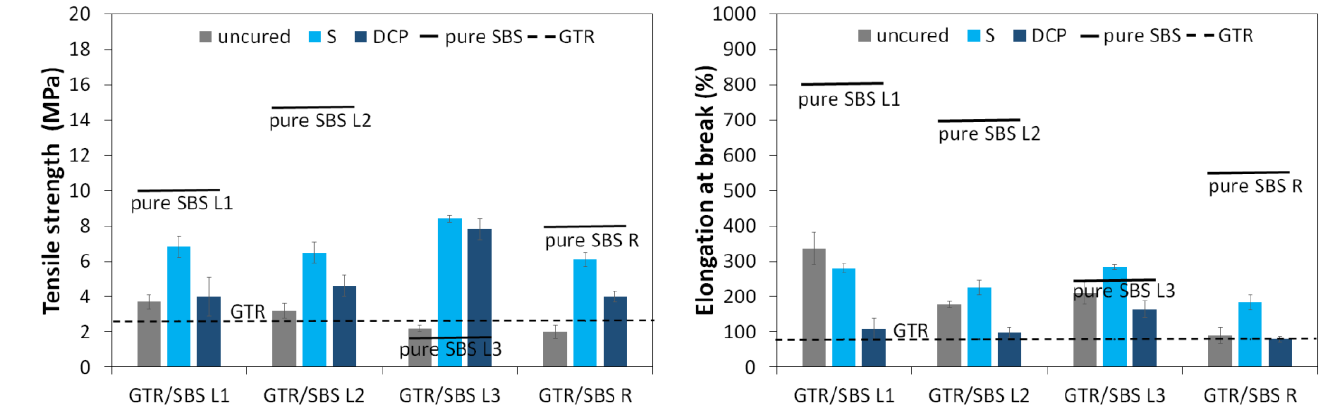
Figure 3. Tensile properties of GTR/SBS blends as function of SBS grade and curing system (data for GTR adapted from [52]; data for pure SBS copolymers were provided by the manufacturer).